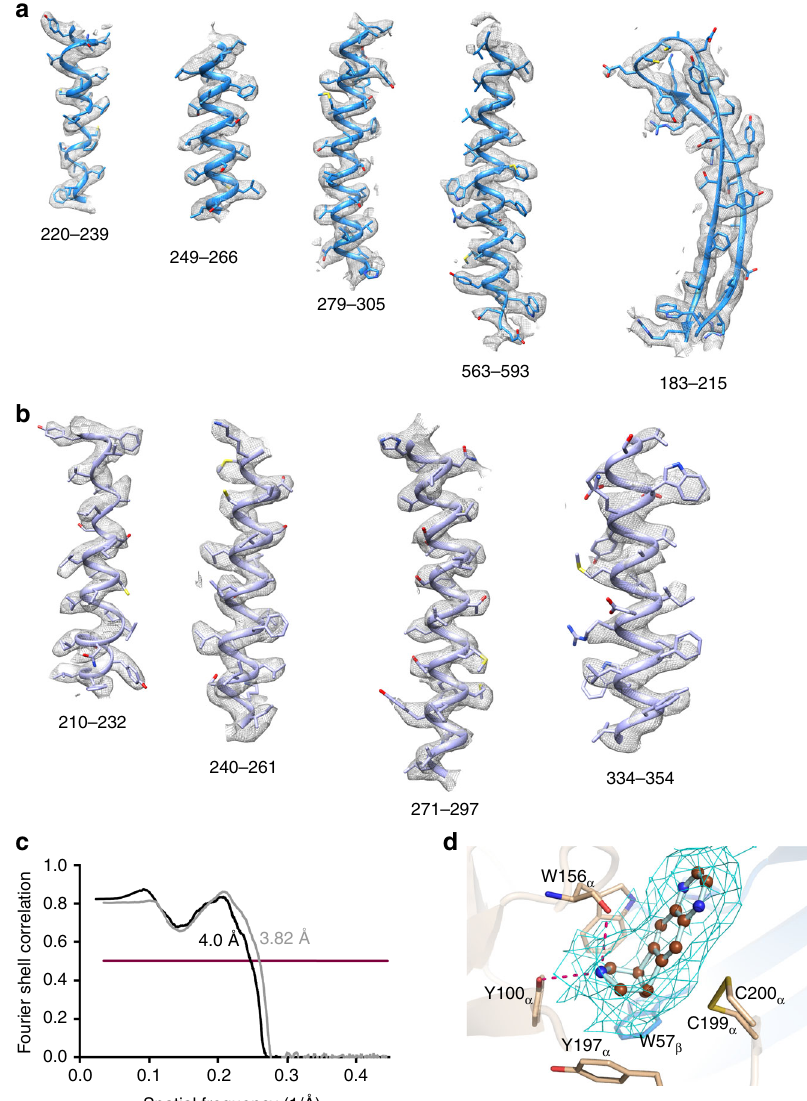
Fig. 7 Model-map validation. Secondary structure elements of a representative a α 4 subunit and b β 2 subunit are shown fi tted to the cryoEM maps c Fourier shell correlation (FSC) curve for the model vs map focused on α 4 β 2 receptor (gray) and vs map of α 4 β 2:sAB complex (black) with indicated resolutions at FSC = 0.5. d CryoEM map (mesh) density accounting for varenicline in the binding pocket. Selected residues on β 2 subunit (marine) and on α 4 subunit (wheat) in contact with the compound are shown. H-bonding interactions between the piperidine nitrogen of varenicline and the aa residues are highlighted in